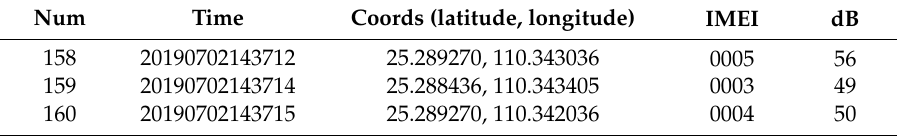
Table 2. Data information in MySQL (My Structured Query